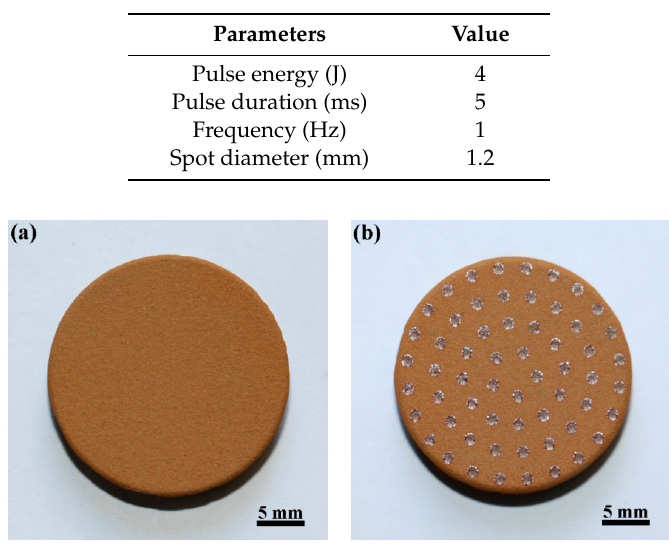
Figure 2. Surface images of specimens: ( a ) plasma-sprayed specimen; ( b ) dotted specimen.